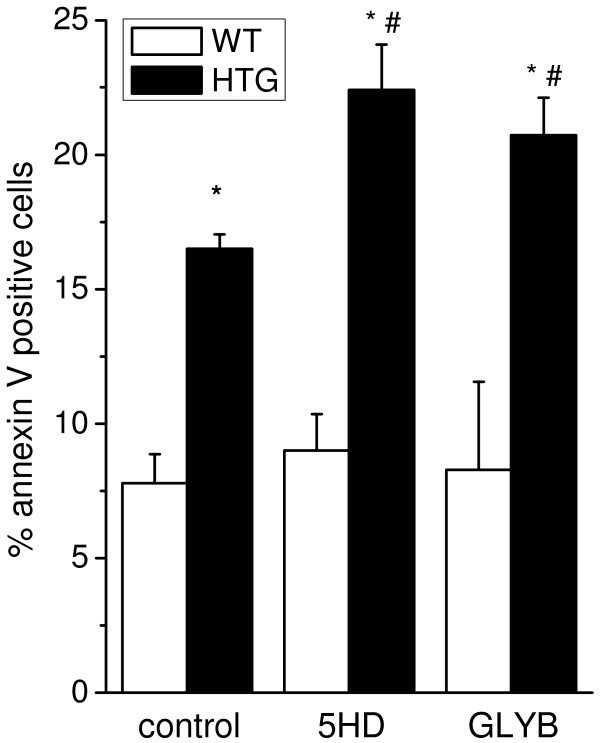
MitoKATP opening partially prevents enhanced apoptotic cell death in spleen mononuclear cells from HTG mice. HTG and WT cells (106 cells) were incubated for 20 min in binding buffer containing annexin V-FITC and 7-AAD, 10 μM DPI, at 37°C, in the absence (control) or presence of 1 mM 5HD or 10 μM GLYB, as described in the Materials and Methods Section. The results are expressed as means ± SEM, n = 5. *P < 0.01 vs. WT under same conditions; #P < 0.05 vs. HTG under control conditions.